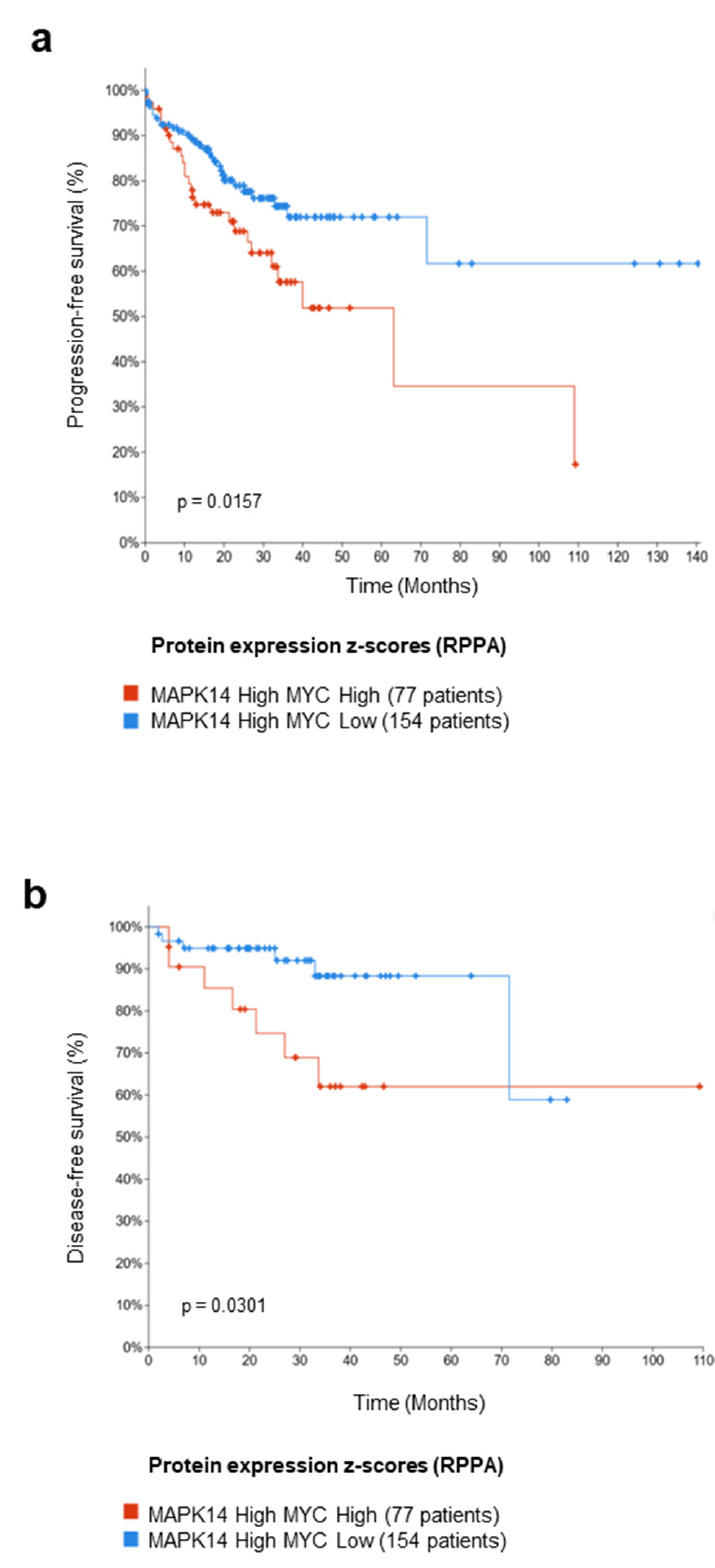
Figure 7. High protein expression levels of p38 α and c-MYC are potential predictive biomarkers for therapy efficacy in CRC patients. ( a , b ) Kaplan–Meier curve of progression-free survival (PFS) ( a ) and disease-free survival (DFS) ( b ) in CRC patients as a function of p38 α (MAPK14) and c-MYC (MYC) protein levels based on clinical data of 581 CRC patients retrieved from TCGA PanCancer Atlas.